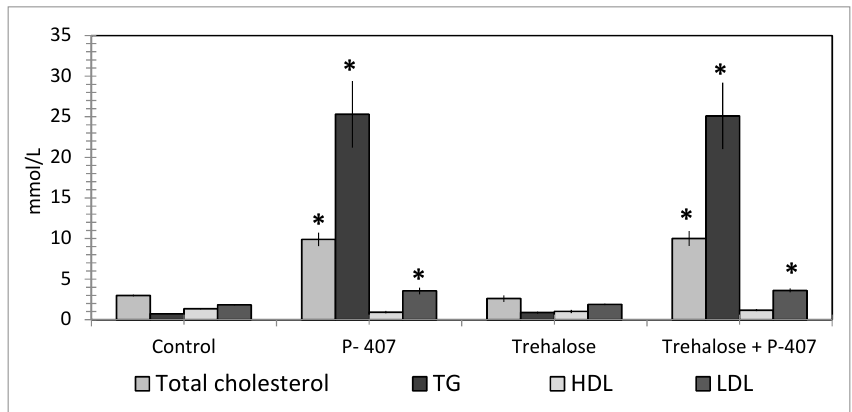
Figure 4. The serum lipid profile of mice with acute lipemia that were drinking a 2% solution of disaccharide trehalose for 10 days before P-407 administration. * p < 0.01 as compared to the